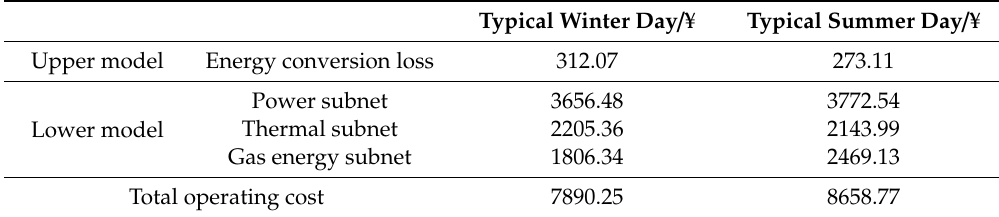
Table 5. The comprehensive operating costs under the two operation modes of typical winter and summer days.